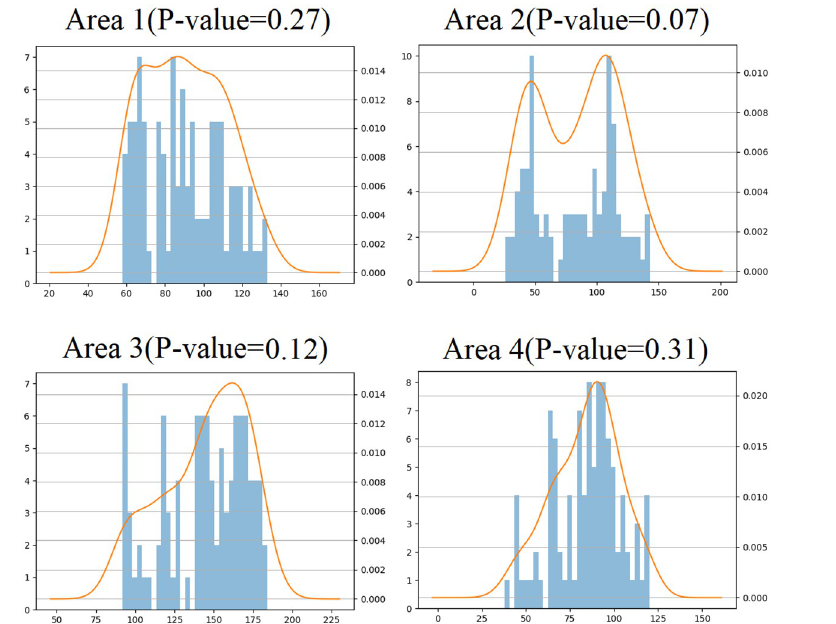
Fig 3. Comparison of fitting results obtained using different semivariogram